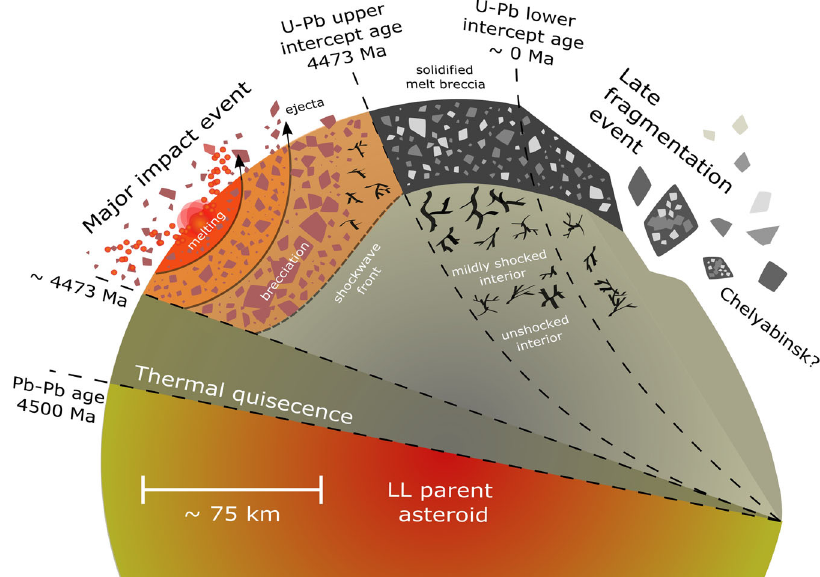
Fig. 5 Proposed formation history of the Chelyabinsk meteorite. Schematic view of collisions affecting the source material of Chelyabinsk on the LL parent body. Early radiogenic metamorphism gives way to cooling of the parent body. A primary collision locally produces shock melt at the surface of the asteroid, which cools relatively quickly (shock-induced features incompletely annealed during post-shock thermal metamorphism). A later spalling event is then needed to liberate the Chelyabinsk material from the LL parent body, and may be responsible for late Pb loss and lower intercept